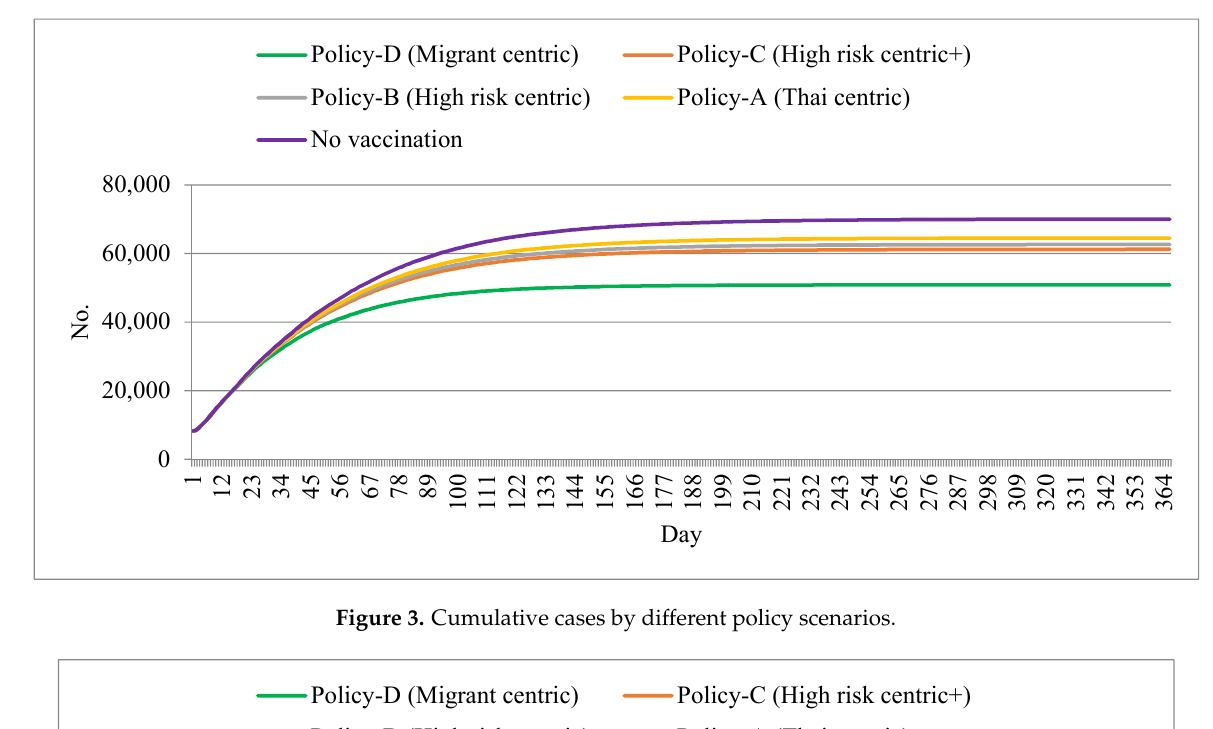
Figure 3. Cumulative cases by different policy scenarios.